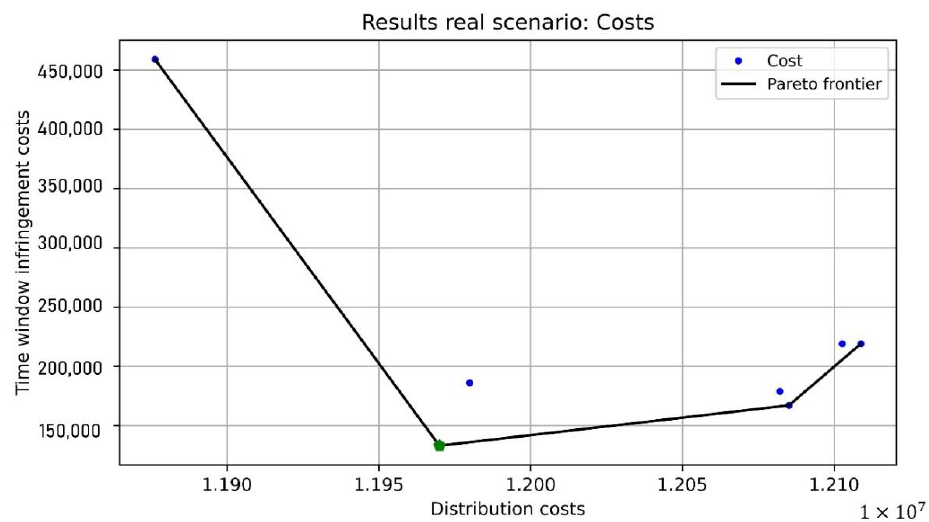
Figure 9. Pareto frontier for the case study application.